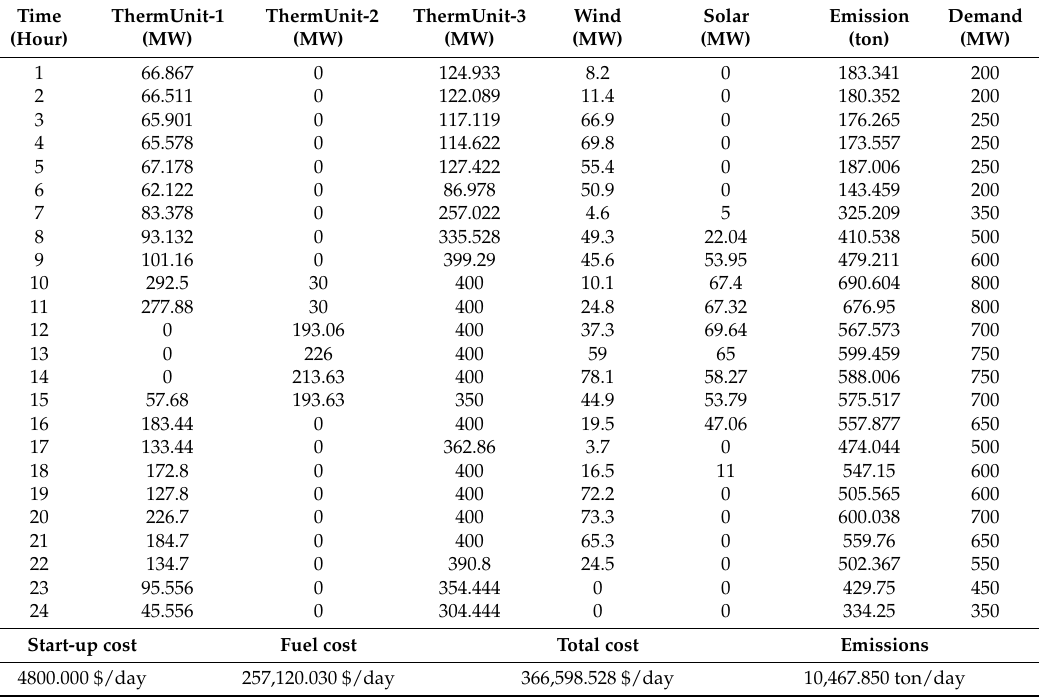
Table 7. Integration of RESs (Wind-Solar) with base three thermal generating units’ simulation results by using the WCOA.